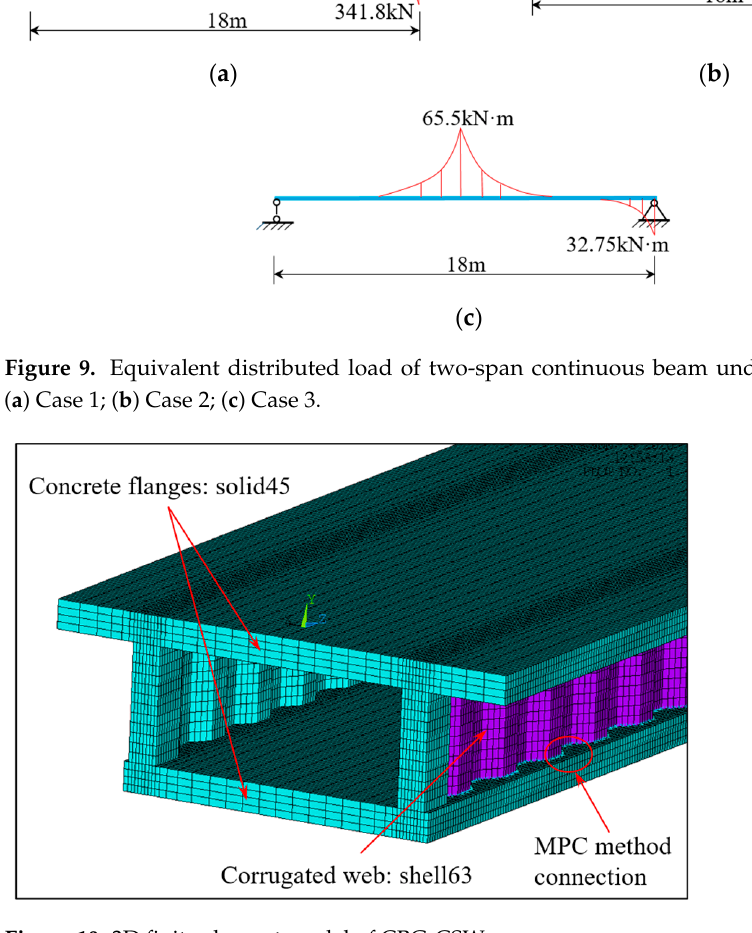
Figure 10. 3D finite element model of CBG-CSWs.